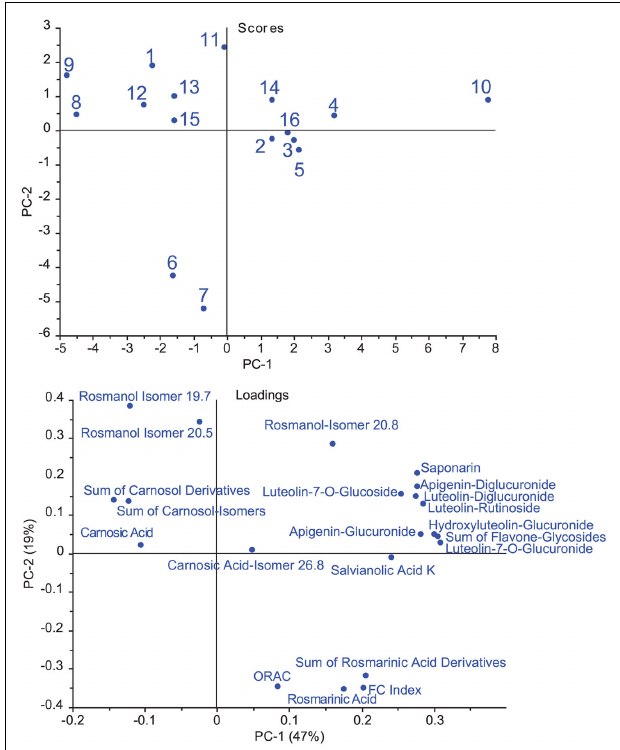
FIGURE 1 | Explorative data analysis of the analytical results of 16 commercial sage tea infusions. The principal component analysis (PCA) plots show the scores (sample numbers 1–16; upper panel) and loadings (names of analytes; lower panel).